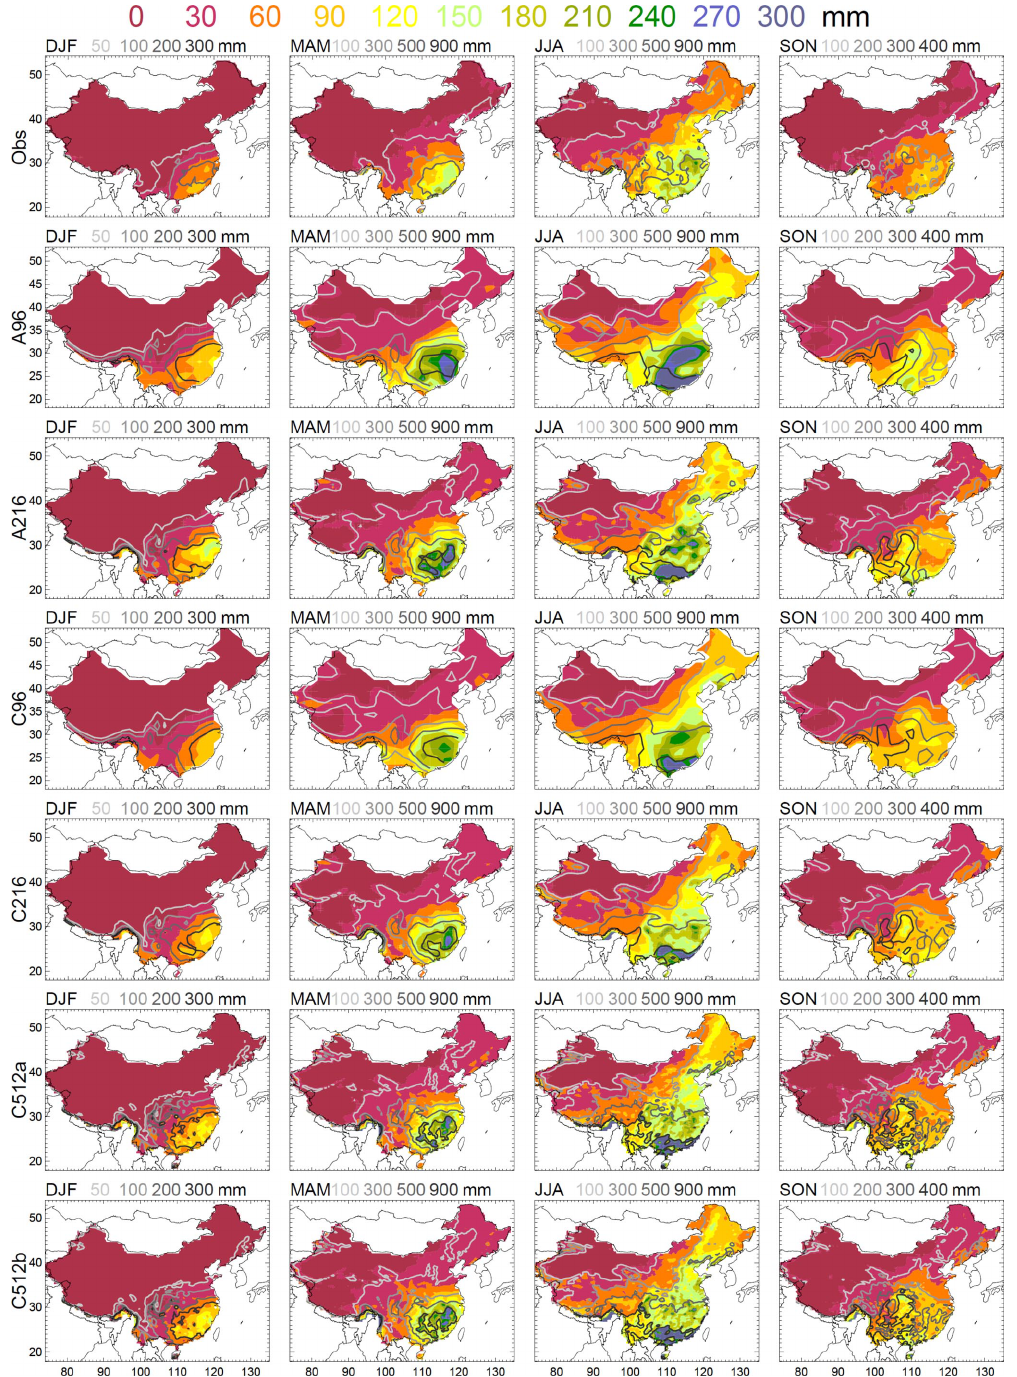
Figure 2. Climatological seasonal total precipitation (grey contours) and interannual standard deviation (shading) for 1951–2007 observations (top) and the full length of each simulation. The season is indicated above the